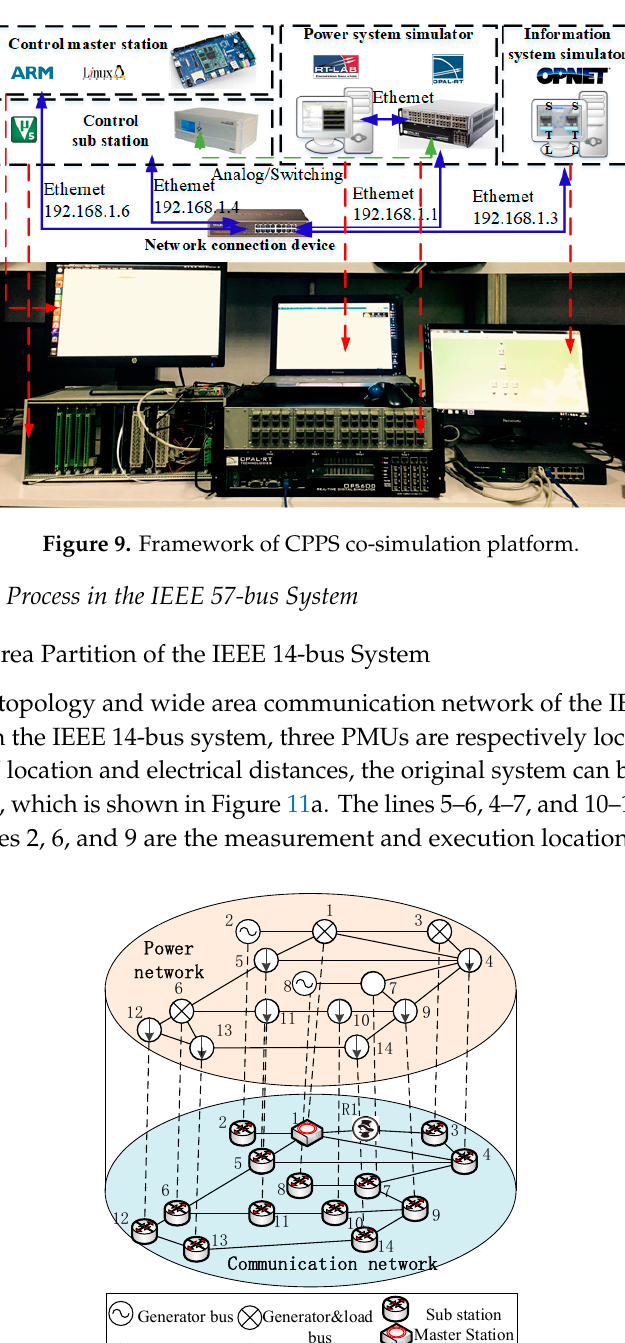
( b ) Figure 11. Topology of the IEEE 14-bus system. ( a ) Topology of the power system; ( b ) topology of the communication system. 7.1.2. Attack Consequences of DDoS Attacks The attack period is set from 100 s to 400 s. During the attack, the delay of each line will increase sharply. Due to the two-way transmission, the delay can be divided into the upload delay from substation to server and download delay from server to substation. These lines are assumed to carry the load and frequency measurements, which are uploaded to the server for the subsequent services. During the DDoS attack, the optimal transmission path of power services in each substation may change due to the time delay. According to the Dijkstra optimization algorithm, the shortest path from the main server to each substation is obtained. The accumulated delay is calculated by the delay in each link, which is shown in Figure 12. After DDoS attacks, the upload and download delay are significantly increased. Due to the limit of storage and process ability of the server, the delay of download control commands is larger than the upload delay, overall. With the increase of the distance from the substation to center, the communication delay becomes larger as a whole.